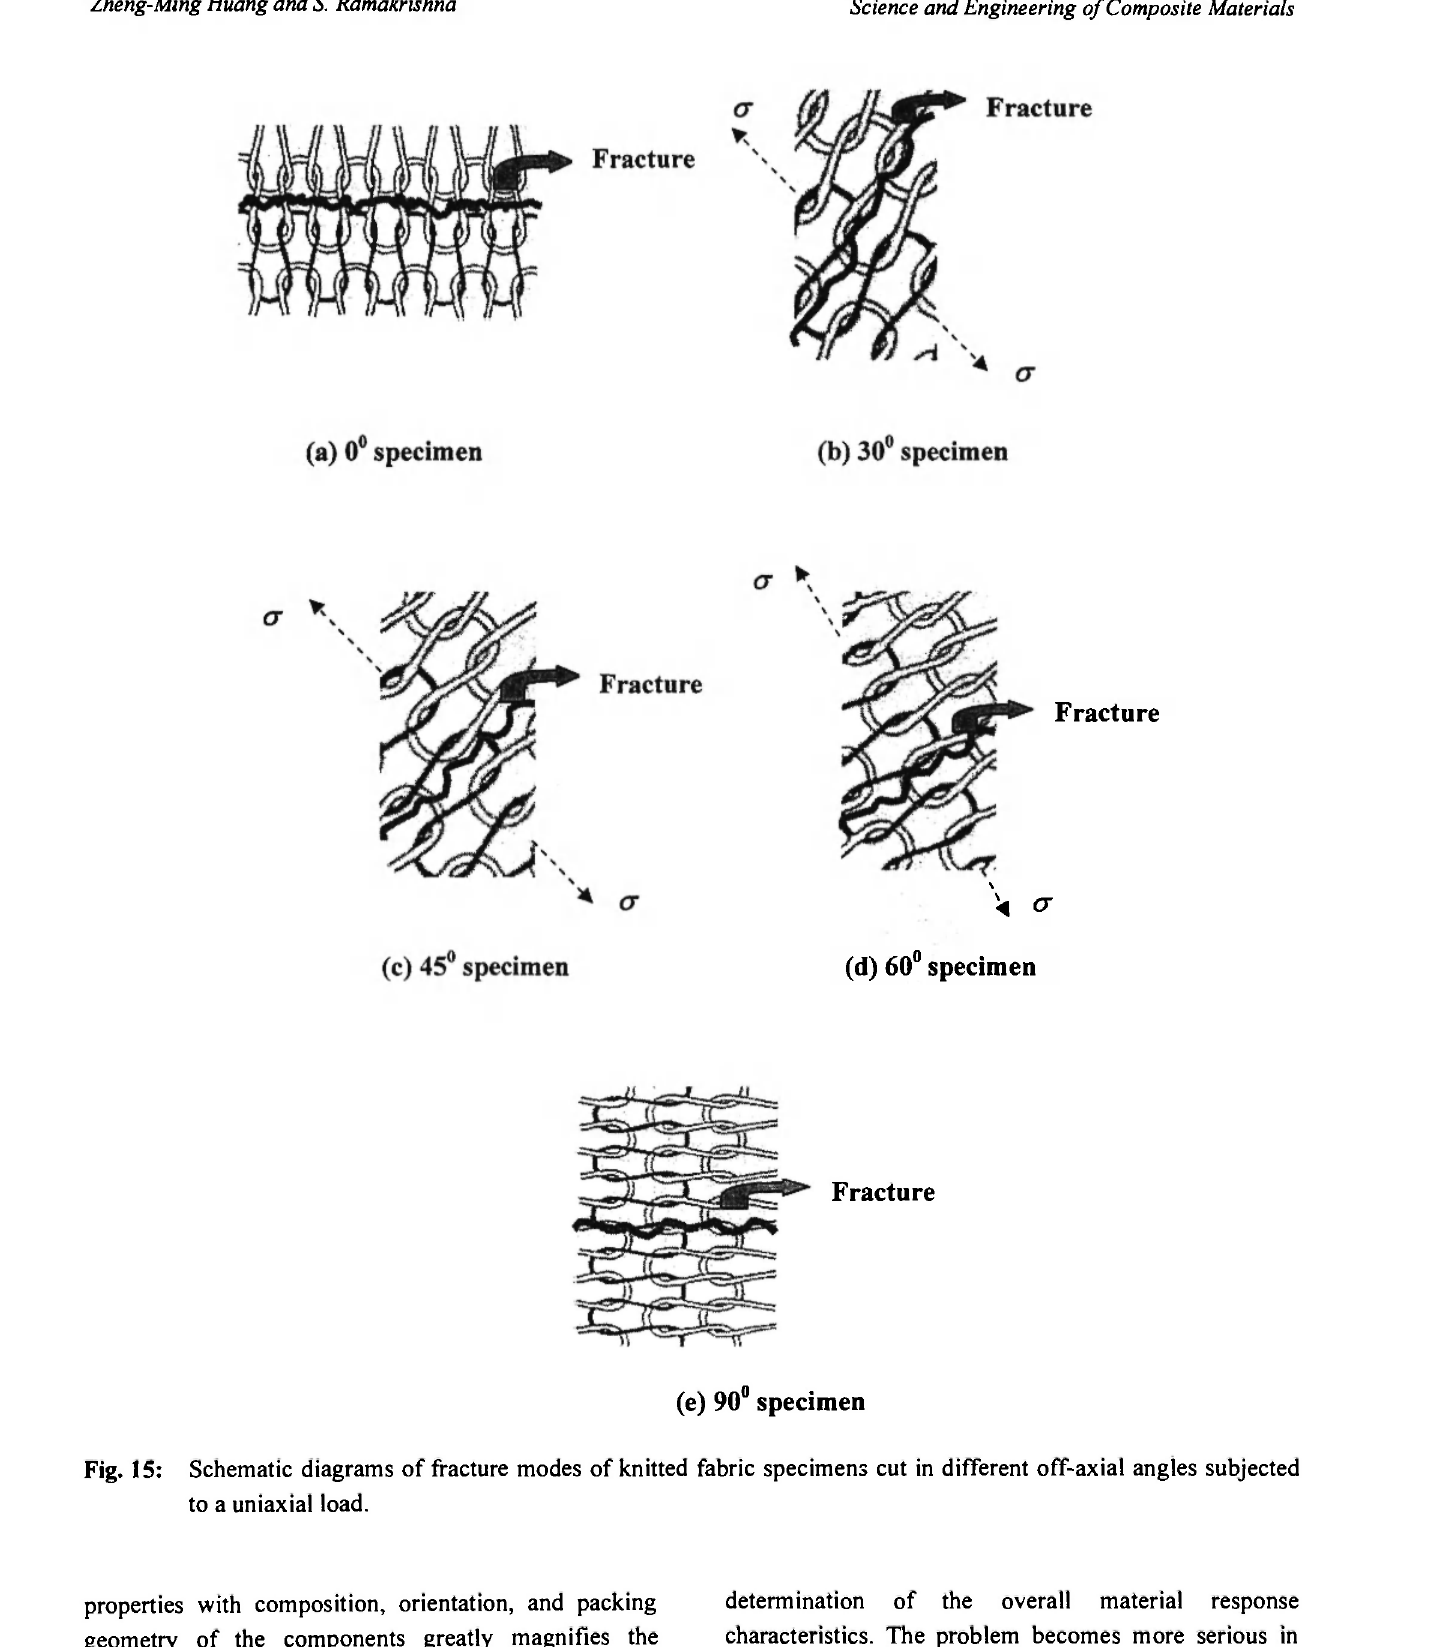
Fig. 15: Schematic diagrams of fracture modes of knitted fabric specimens cut in different off-axial angles subjected to a uniaxial